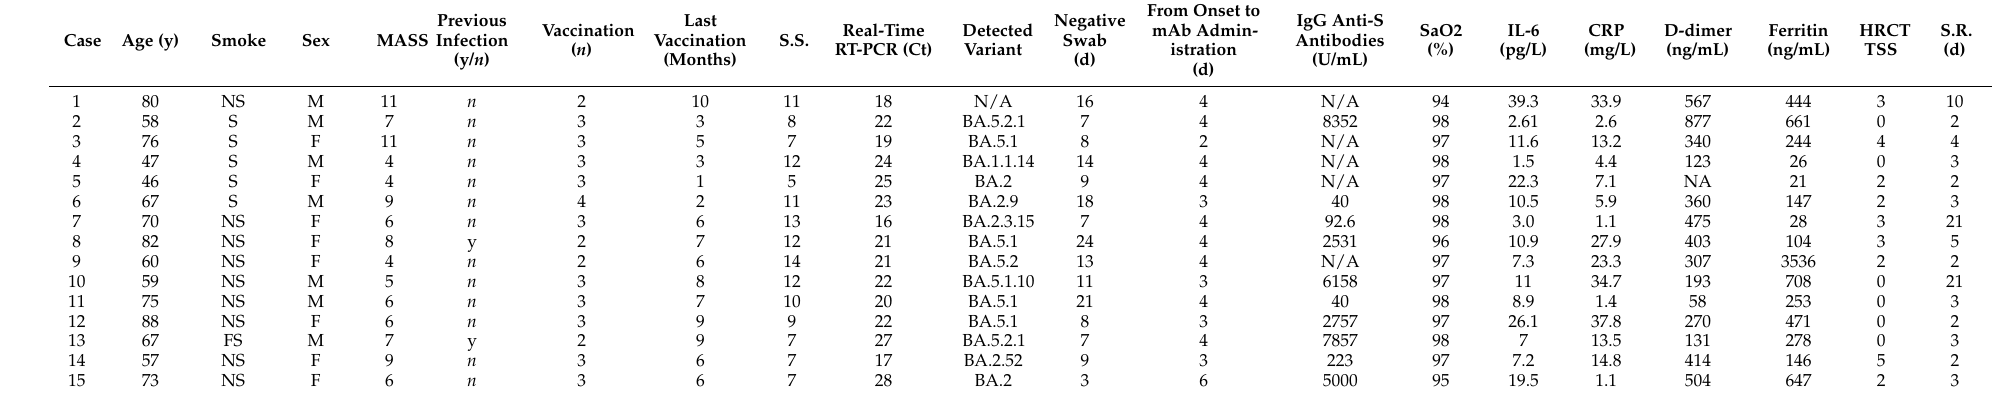
Table 1. Patient signalment, anamnesis and supplementary exam